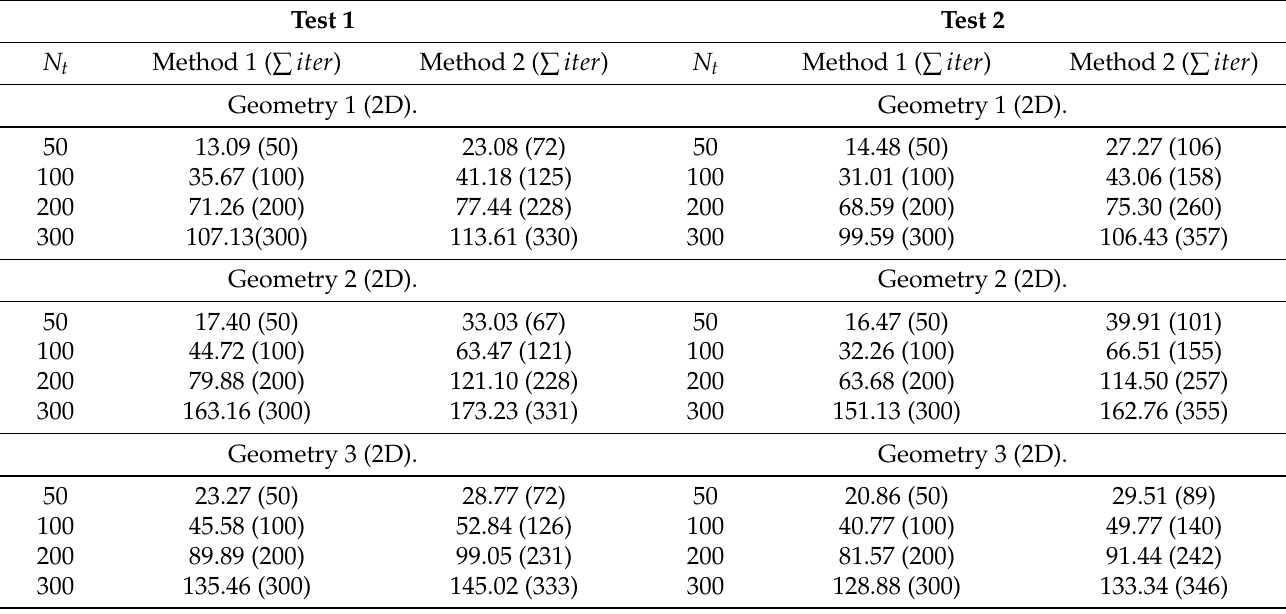
Table 1. Calculation time in seconds with the corresponded number of iterations for two-dimensional problems. ∑ iter is the sum of Picard iterations over time. N t is the number of time steps. Method 1 and 2 are the linearization from the previous time step and Picard iterations method, respectively. Left table: Test 1. Right table: Test